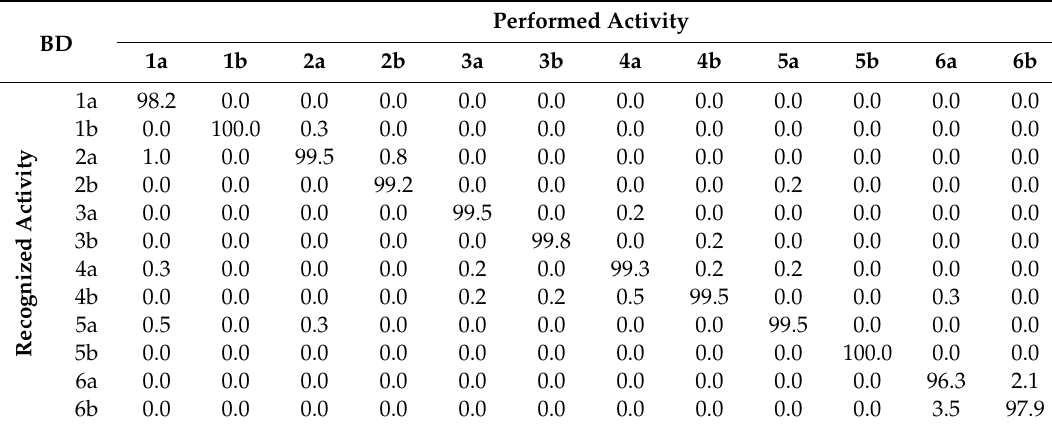
Table A2. Matrix of recognition errors (in %) of 12 motor activities 1a ÷ 6b in test set for all volunteers together for sensor BD.